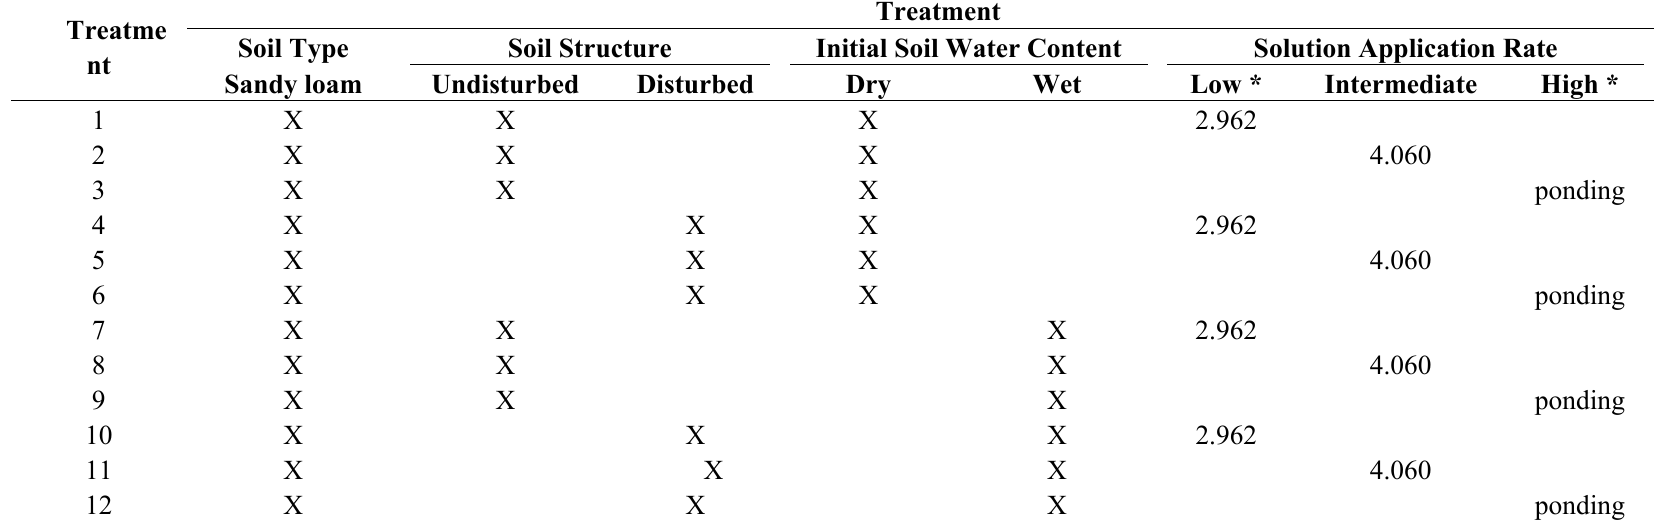
Table 2. Experimental